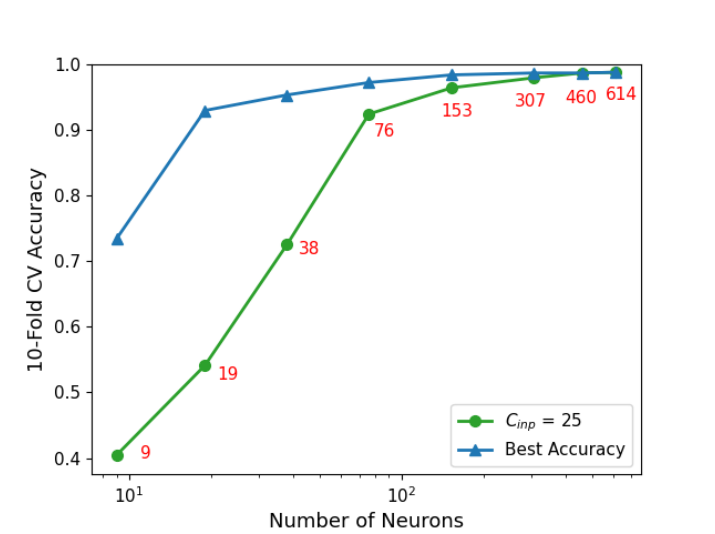
Figure 10. The 10-fold cross-validation accuracy vs. LSM size. Red numbers indicate the exact number of neurons in the network. Green curves follows the accuracy at a fix C inp = 25, while the blue curve gives the best accuracy irrespective of C inp for the given LSM size.